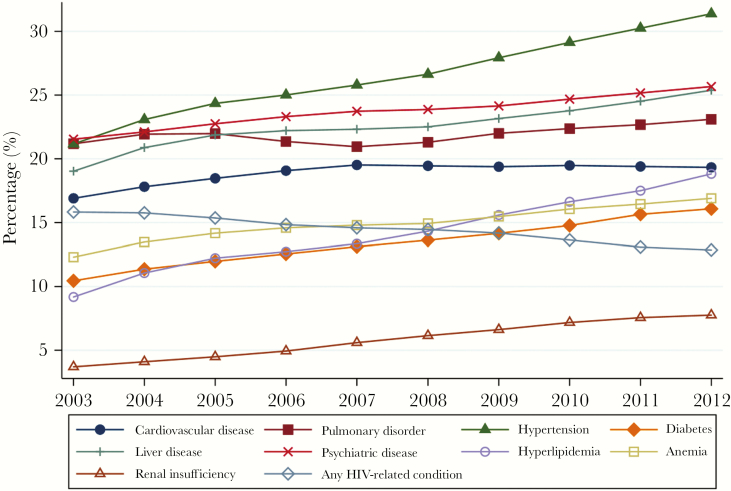
Rates of the top 10 most common comorbid conditions among HIV Medicaid enrollees, 2003–2012. n = 5 848 394 person-quarters. All yearly estimates have P values <.001. The denominator includes all eligible HIV Medicaid enrollees in the analytic cohort. The numerators for each condition include all patients who had evidence of the condition in the last 24 months, as documented in claims. Rates were adjusted for months of eligibility and not adjusted for patient characteristics.